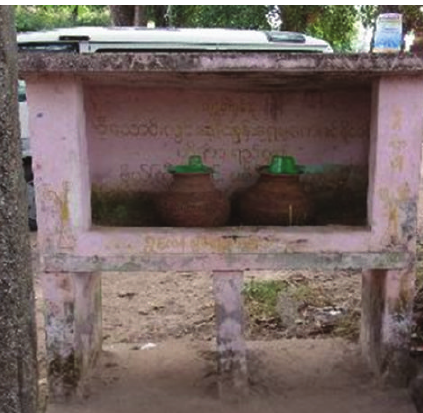
Table 1: Summary of drinking-water samples.